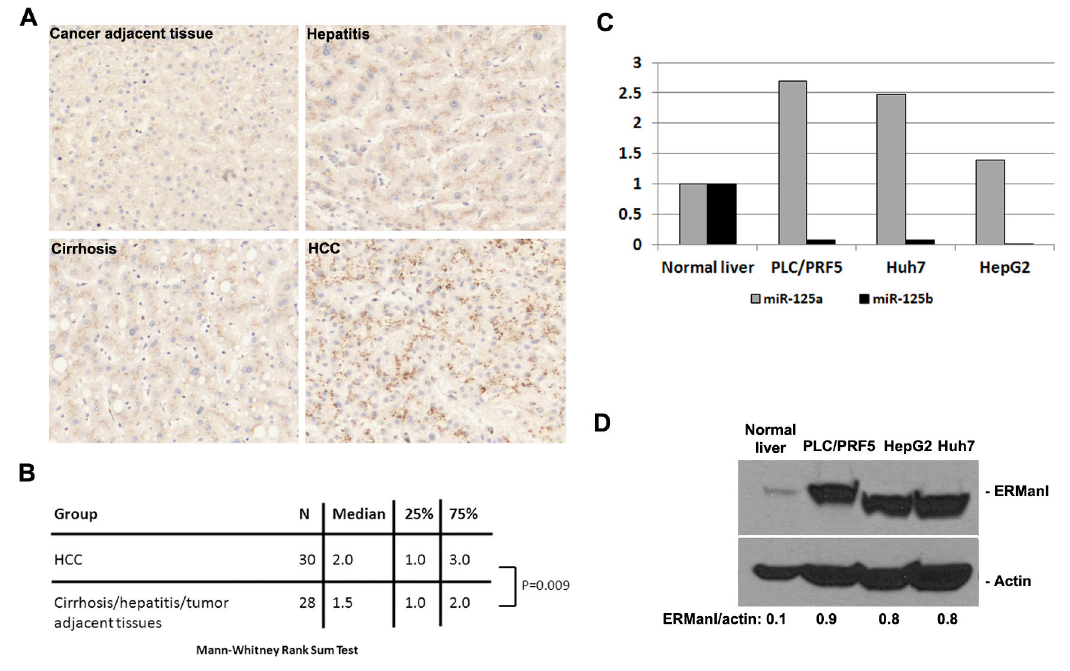
Figure 2. ERManI is upregulated in HCC. A . Representative images of different liver tissues stained with anti-ERManI antibodies. B . Statistical analyses of the HCC and cirrhosis/hepatitis/tumor adjacent tissues using Mann-Whitney Rank Sum Test. The analyses were based on the sample number (N), median, and intensity score at 25% and 75% percentile of each indicated tissue group. C . The percentage of miR-125a and miR-125b is expressed in PLC/PRF5, Huh7, and HepG2 cells lines as compared to that expressed in normal liver tissues. The data are based on the results obtained from real-time RT-PCR. D . Western blotting of ERManI and actin in normal liver and indicated cell lines. Numbers on the bottom represent the relative expression of ERManI normalized against